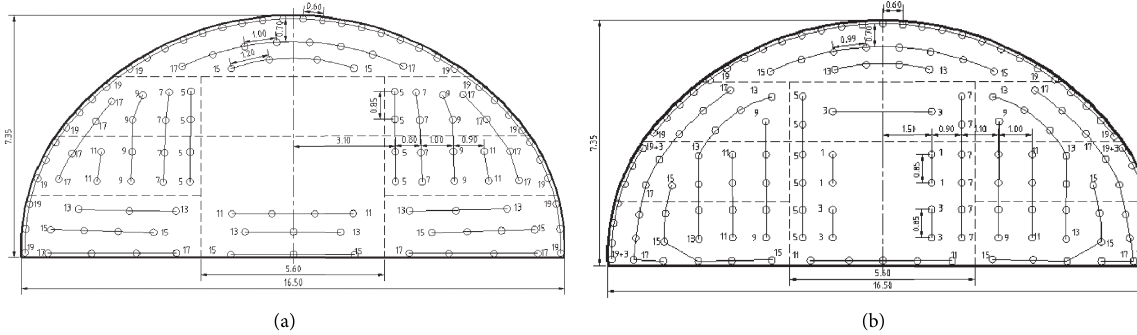
Figure 1: Arrangement of blastholes: (a) 3.0m blasting scheme and (b) 1.5m blasting Figure 5: a comparative analysis of vibration velocity caused